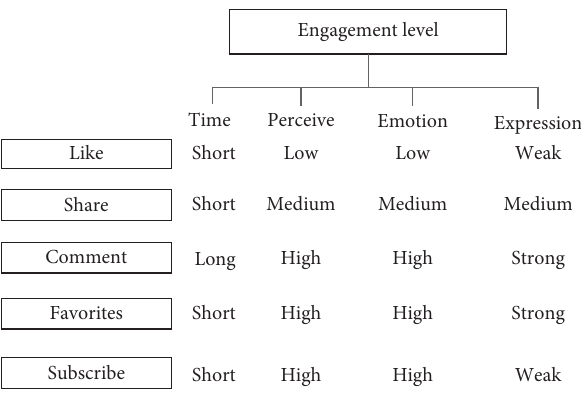
Figure 2: People’s engagement level of interaction behavior